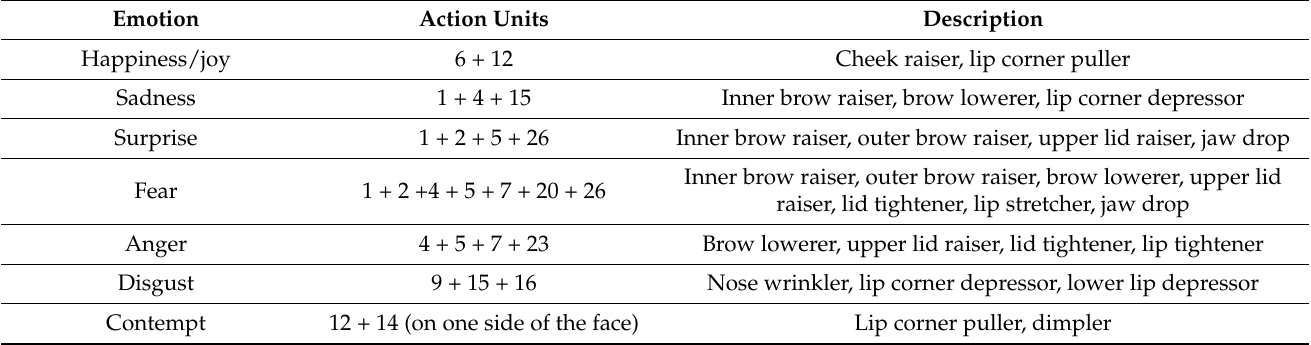
Table 1. Action units of the facial muscle movements expressing emotions in Affective ® https://imotions.com/blog/facial- action-coding-system/.